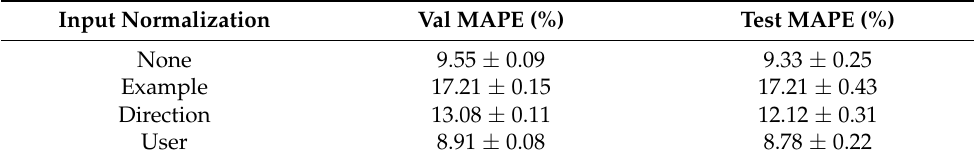
Table 3. Results of regression task using different normalization of raw data.